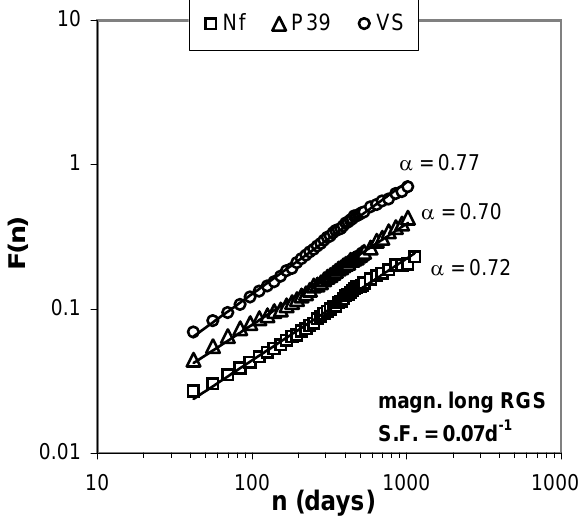
Figure 9 . Log-log plot of the fluctuation function F ( n ) vs. time scale n , for the RGS from Nf, VS